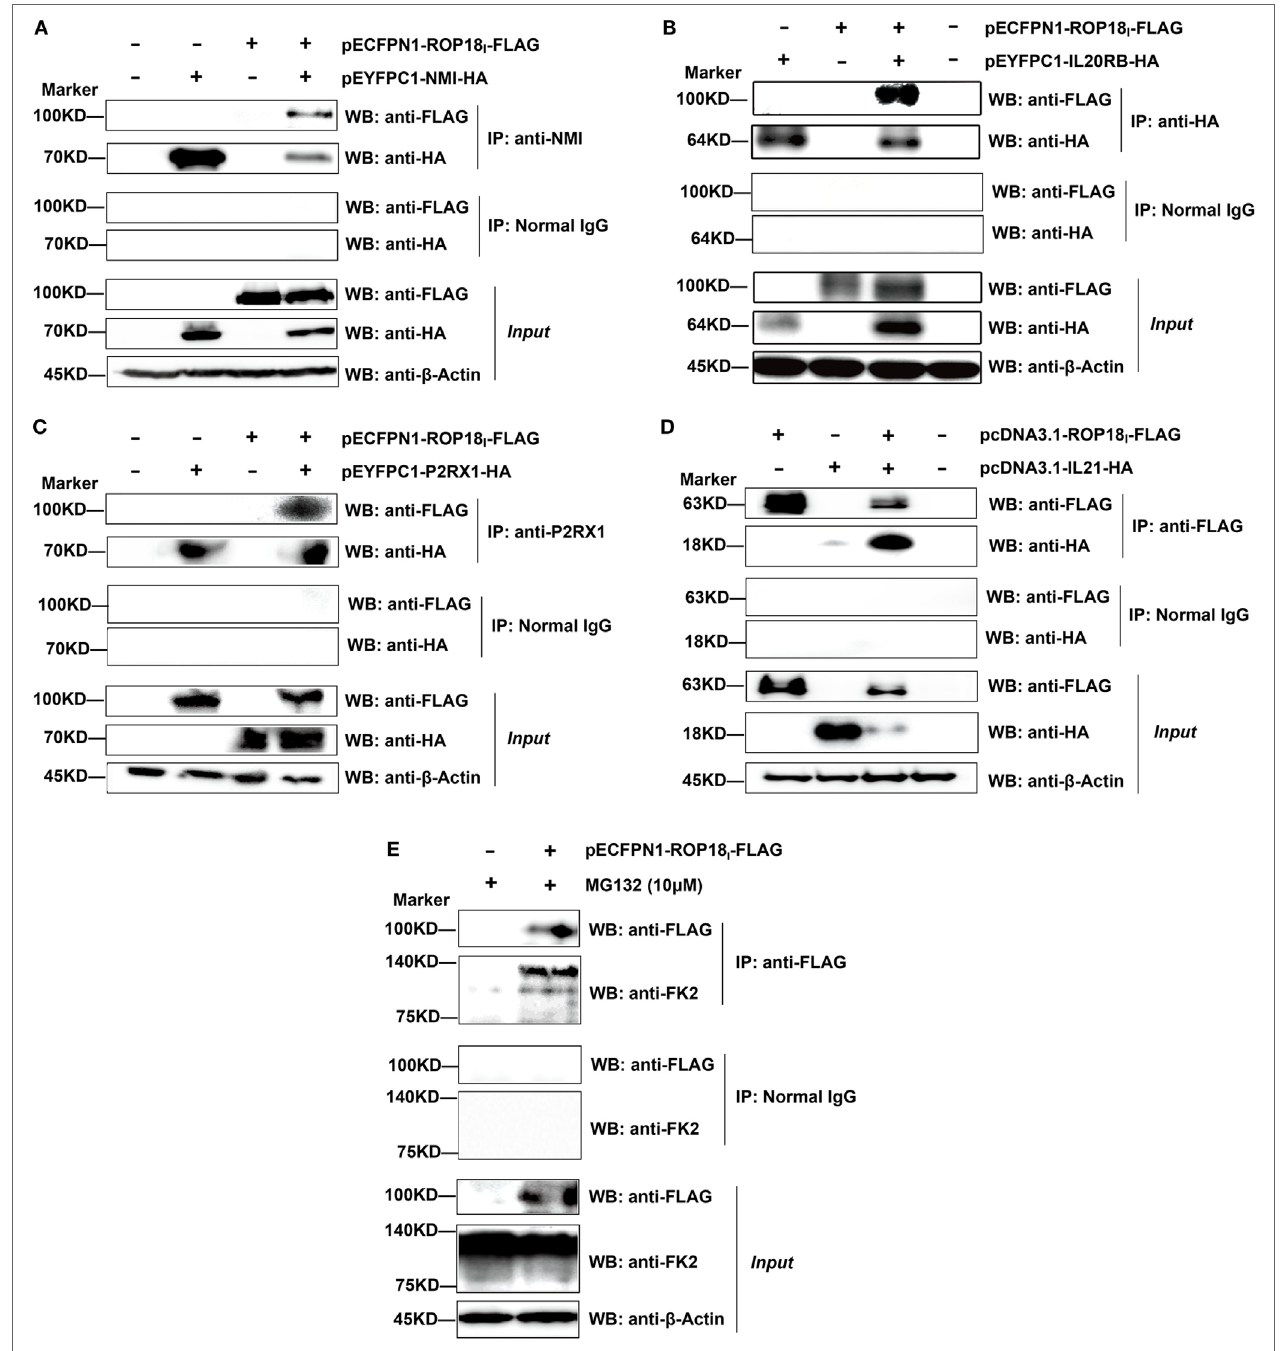
FigUre 3 | Validation of the Tg ROP18-interacting proteins by co-immunoprecipitation (Co-IP) assay. (a–D) Lysates of COS-7 cells co-overexpressing ROP18 I and the indicated interacting proteins were immunoprecipitated with the indicated antibodies. Rabbit, mouse, or goat normal control IgG were used as negative controls. The immunoprecipitates were detected by SDS-PAGE and western blotting using the antibodies indicated. (e) Lysates of COS-7 cells overexpressing ROP18 I in the presence of MG132 (10 µM) for 12 h were immunoprecipitated with the anti-FLAG antibody. Endogenous UBC (a smear of bands) was detected in the immunoprecipitates through western blotting with anti-FK2 antibody, which recognizes mono- and polyubiquitinylated